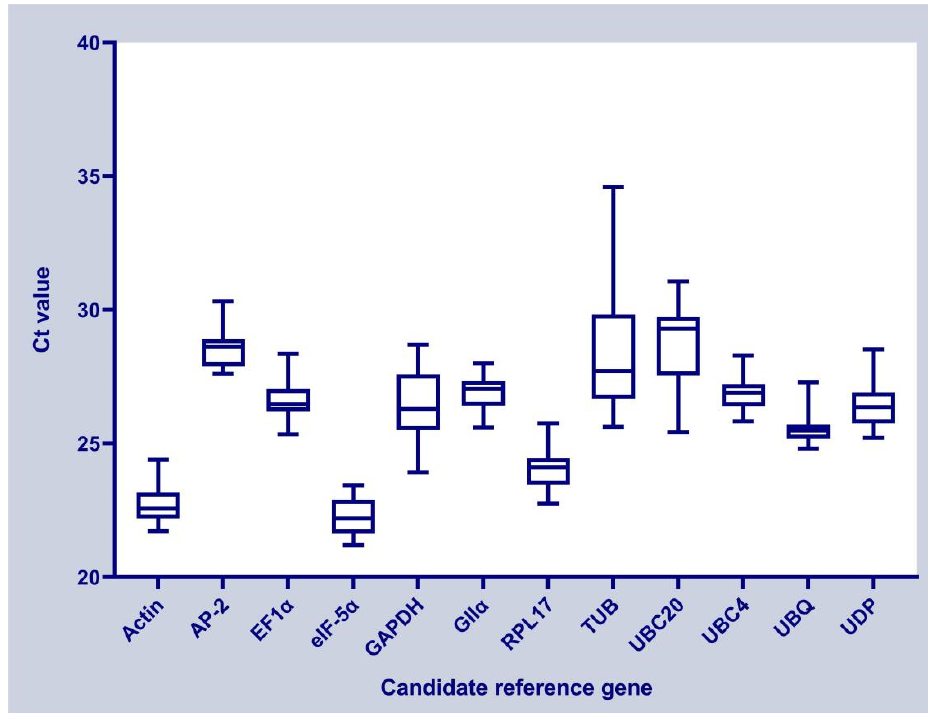
Figure 1. Distribution of Ct values among the 12 candidate reference genes.